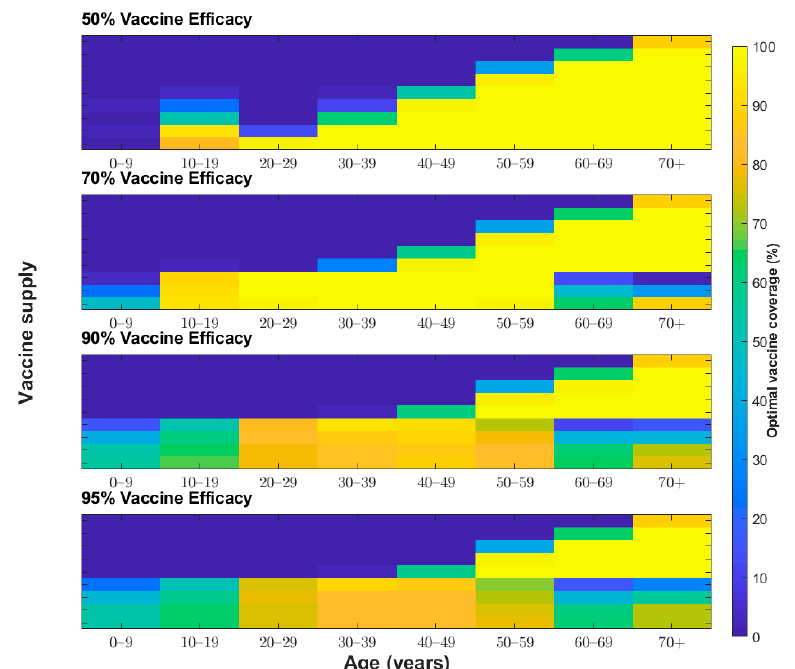
Figure 5. Proportion of individuals vaccinated from each age group ( x -axis) to minimize the total number of deaths associated with COVID-19 under various vaccine coverage levels ( y -axis) and vaccine efficacies (50%, 70%, 90%, and 95%).